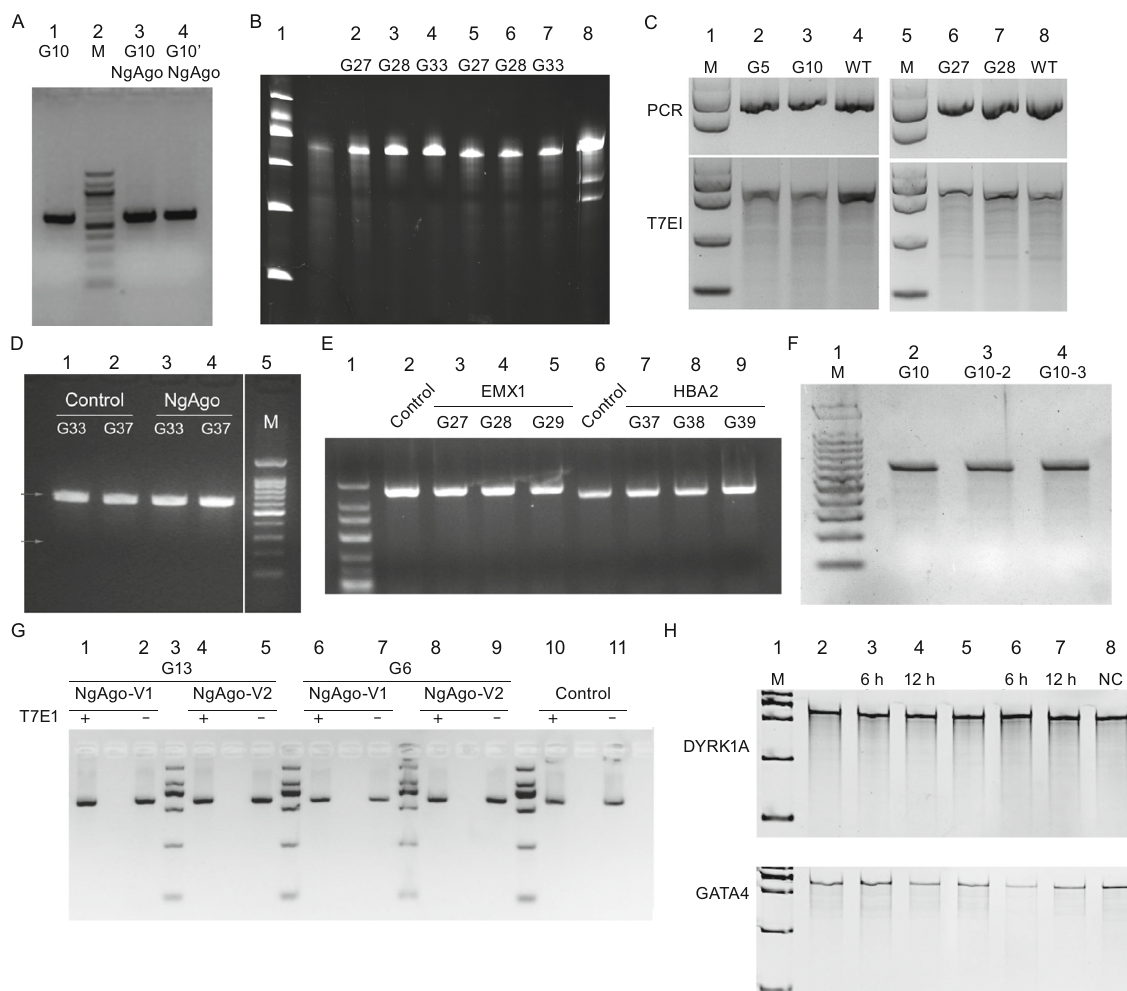
Figure 1. Results from repeating Fig 4 data of Gao et al using DNA guides with identical sequences and genomic targets . (A) T7E1 assay of NgAgo targeting DYRK1A using 293T cells. 1, Control, transfected with G10 only; 2, Marker; 3, Transfected with G10 and NgAgo; 4, Transfected with G10 plus G10 complementary oligo and NgAgo. (B) T7E1 assay of NgAgo targeting DYRK1A using 293Tcells. 1, Marker; 2, 3 and 4, Controls transfected with G27, G28 or G33 guides only; 5, 6 and 7, Transfected with G27, G28 or G33 guides and NgAgo; 8, Positive control that con fi rms T7E1 ’ s activity. (C) T7E1 assay of NgAgo targeting DYRK1A and EMX1 using 293Tcells. 1 and 5, Marker; 2 and 3, transfected with G5 or G10 and NgAgo for DYRK1A; 6 and 7, transfected with G27 or G28 with NgAgo for EMX1. 4 and 8, Not transfected. Upper panel: PCR products only. Lower panel: T7E1 assay. (D) T7E1 assay of NgAgo targeting EMX1 and HBA2 using 293Tcells. 1 and 2, transfected with G33 or G37 only; 3 and 4, transfected with G27 or G37 and NgAgo. (E) T7E1 assay of NgAgo targeting EMX1 and HBA2 using 293Tcells. 1, Marker; 2 and 6, Control using a guide against GFP; 3, 4 and 5, transfected with G33 or G37 only; 3 and 4 transfected with G27, G28 or G29 and NgAgo for EMX1. 7, 8 and 9, transfected with G37, G38 or G39 and NgAgo for HBA2. (F) T7E1 assay of NgAgo targeting DYRK1A using 293Tcells. 1, Marker; 2, Transfected with 500 ng G10 and 1 μ g NgAgo; 3, Transfected with 1 μ g G10 and 1 μ g NgAgo; 4, Transfected with 500 ng G10 and 1 μ g NgAgo, transfected 500 ng G10 again after 12 h. (G) T7E1 assay of NgAgo targeting DYRK1A using 293T cells. 1 and 6, Transfected with G13 or G6 and NgAgo-V1 for DYRK1A; 3, Marker; 4 and 8, Transfected with G13 or and NgAgo-V2 for DYRK1A; 2 and 7, Transfected with G13 or G6 and NgAgo-V1 for DYRK1A without T7E1; 5 and 9, Transfected with G13 or G6 and NgAgo-V1 for DYRK1A without T7E1; 10, Not transfected; 11, Not transfected without T7E1. NgAgo-V1: NLS-NgAgo-NLS. NgAgo-V2: NLS-NgAgo (codon optimization). (H) Surveyor assay of NgAgo targeting DYRK1A and GATA4 using 293T cells. 200 ng archaea codon NgAgo (aNgAgo) or codon humanized NgAgo (hNgAgo)-expressing plasmids were co-transfected with 500 ng G10 of DYRK1A or G41 of GATA4 gDNA into 293Tcells respectively. gDNAs of DYRK1A and GATA4 were re-transfected 6 h or 12 h later as labeled. 1. Marker; 2, 3 and 4. aNgAgo; 5, 6 and 7. hNgAgo. 8. Not transfected control. Data sources: (A) Shuo Lin; (B) Zhiwei Huang; (C) Wei Li; (D) Jing-Wei Xiong; (E) Junjiu Huang and Zhou Songyang; (F) Wensheng Wei; (G) Hui Yang; (H) Haoyi